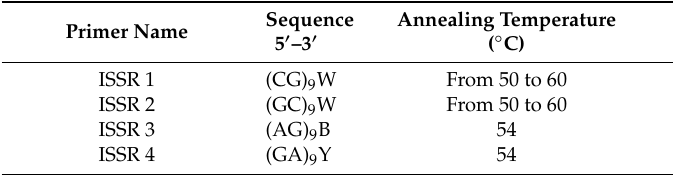
Table 4. List of the ISSR primers used in this study, their sequences, and the annealing temperature applied to each. (W = A or T, Y = C or T, B = T, or C or